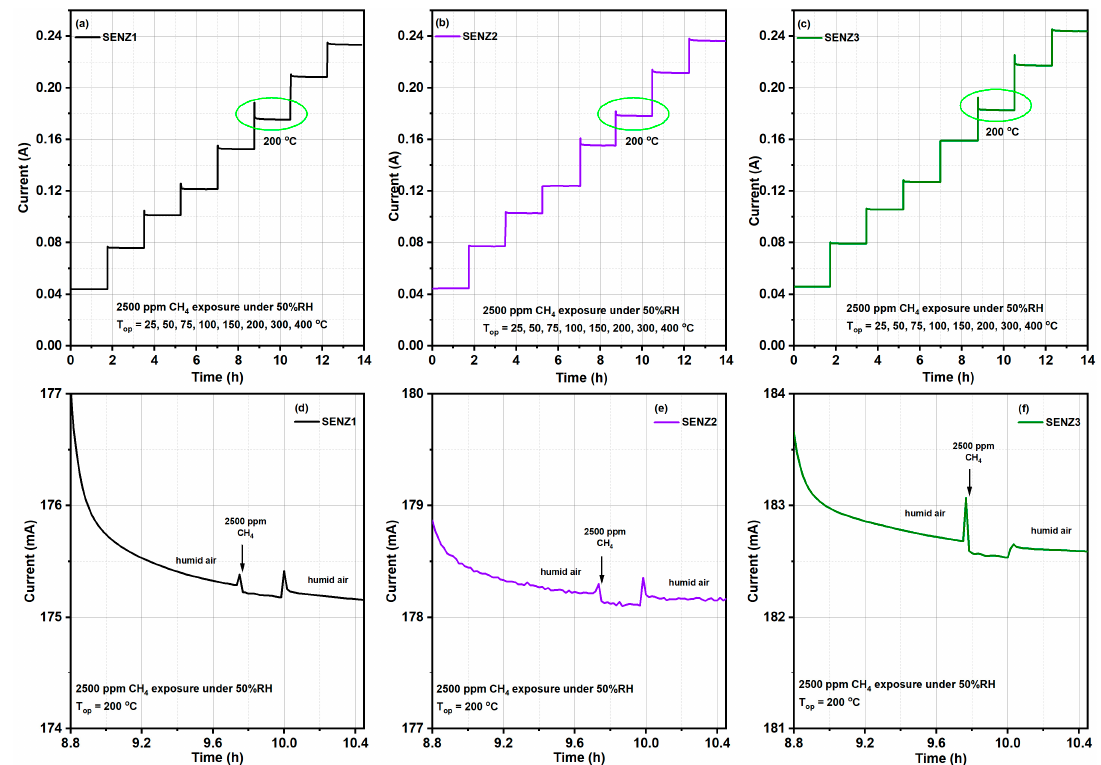
Figure 8. The electrical current dependence through the platinum heater of different catalytic micro-converters based on CeMn/LaAl catalysts with respect to the: ( a – c ) operating temperatures from 25 °C to 400 °C; ( d – f ) humid air-2500 ppm CH 4 pulse-humid air @200 °C under 50% RH.